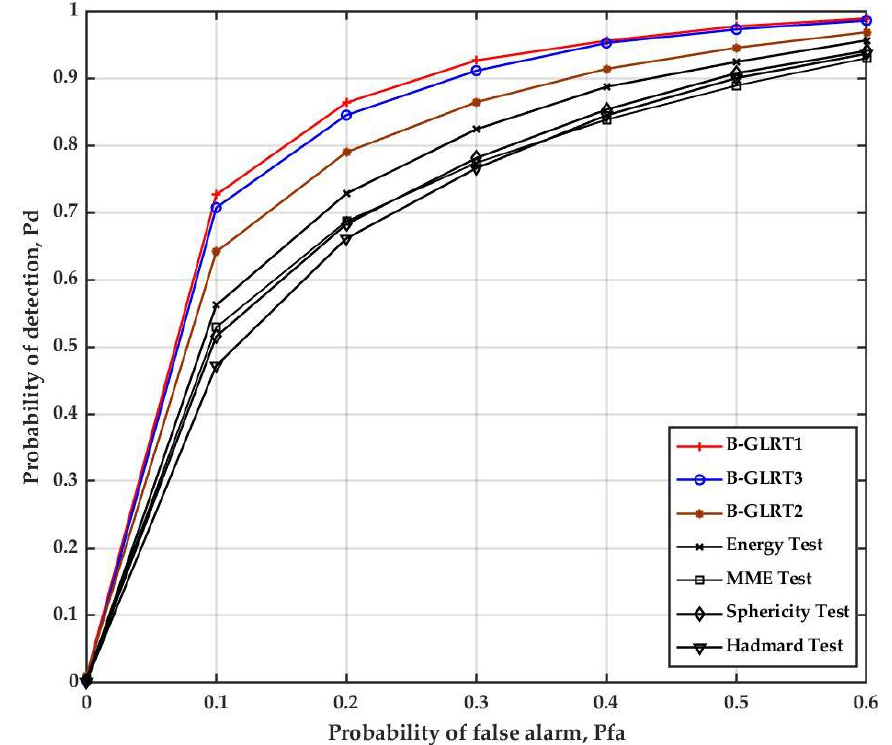
Figure 6. Probability of detection versus probability of false alarm at SNR = − 3 dB, N r = 3, N t = 2 and L = 20.